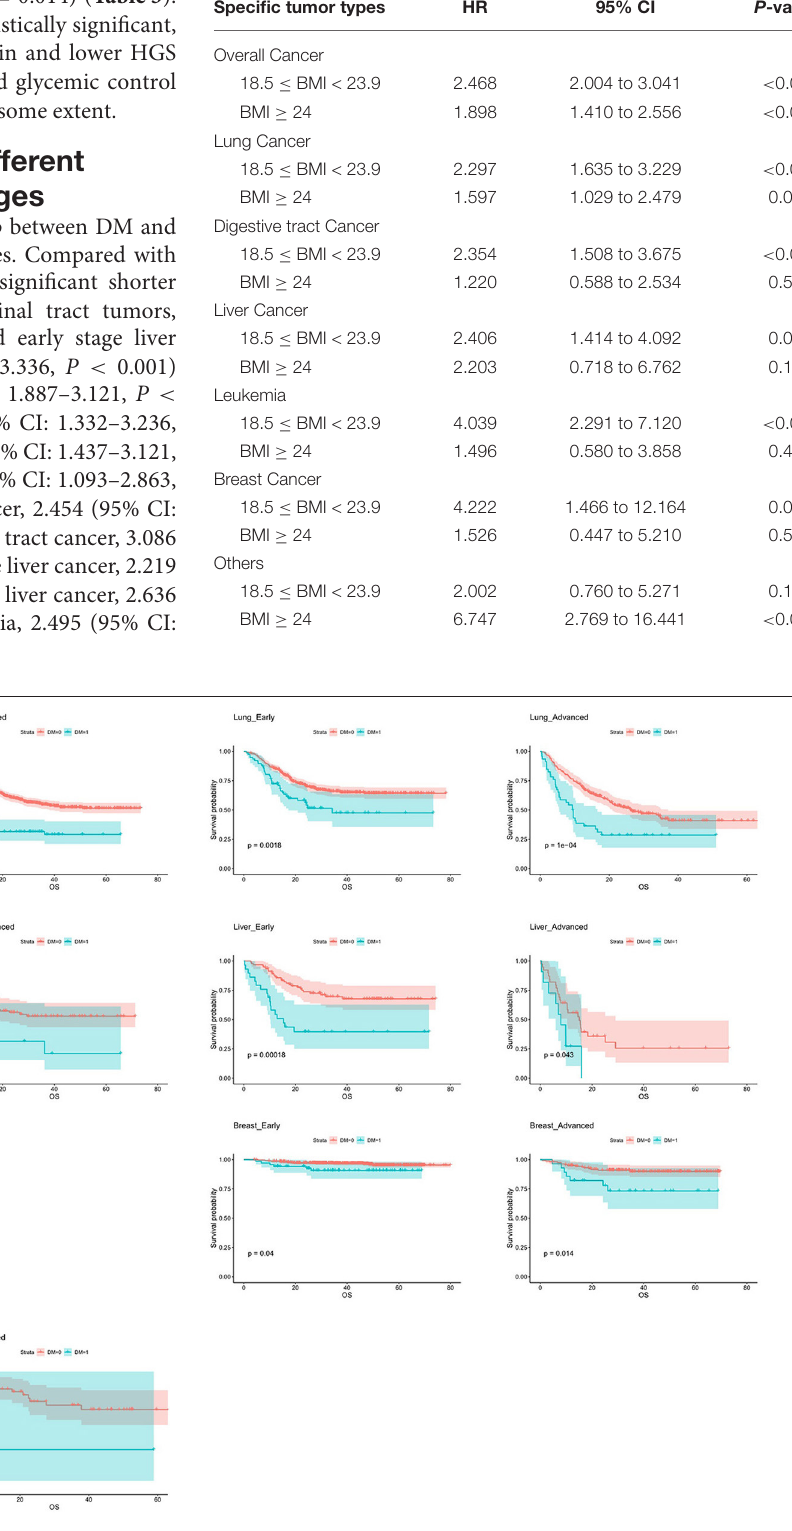
Frontiers in Nutrition |